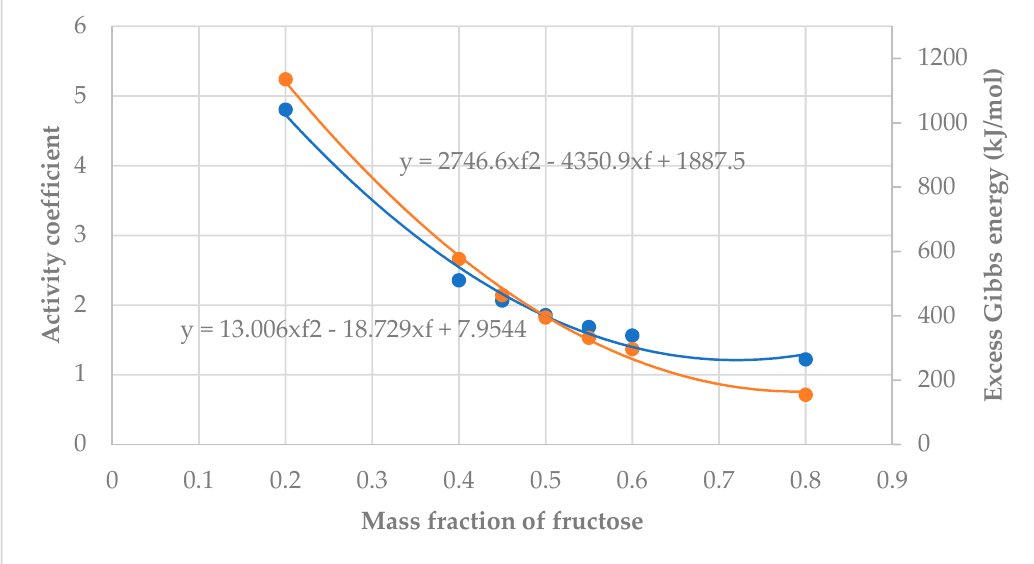
Figure 11. Activity coefficient (blue) and Excess Gibbs Energy (orange) vs. mass fraction of fructose. xylitol: y xylitol = 13.915x 2 − 19.874x + 8.2945 and fructose: y fructose = 13.006x 2 − 18.729x + 7.9544. Excess Gibbs Energy versus mole fractions were: E xylitol (blue): G = 3279.5x 2 − 5044.6x + 2097.7 and xyltiol E fructose (orange line): G = 2746.6x 2 − 4350.9x + fructose